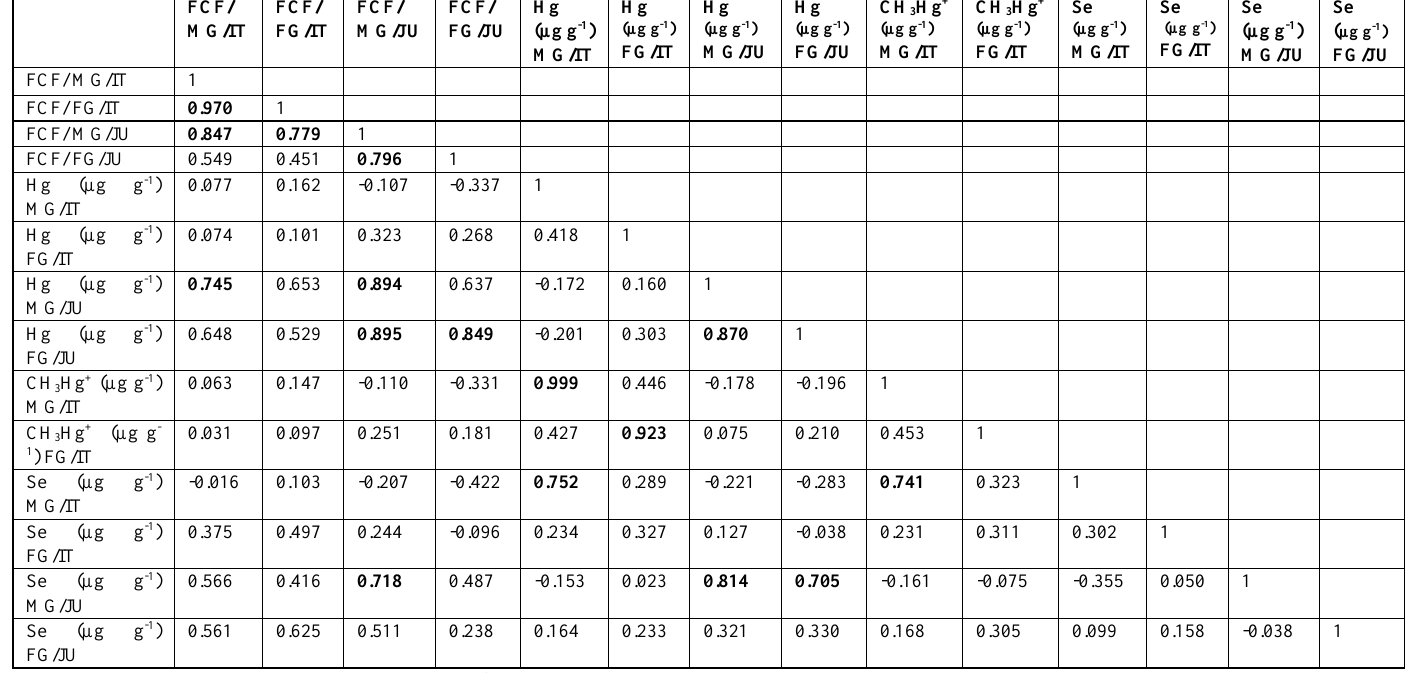
Table 4: Interaction between fish consumption frequency, Hg and CH 3 Hg + concentrations in hair samples of riverine inhabitants belonging to Barreiras community (area impacted by gold mining underground) and Tabatinga community (area without mining impact), masculine genus and feminine genus, belonging to the Tapajós basin, Pará state (Amazon, Brazil).